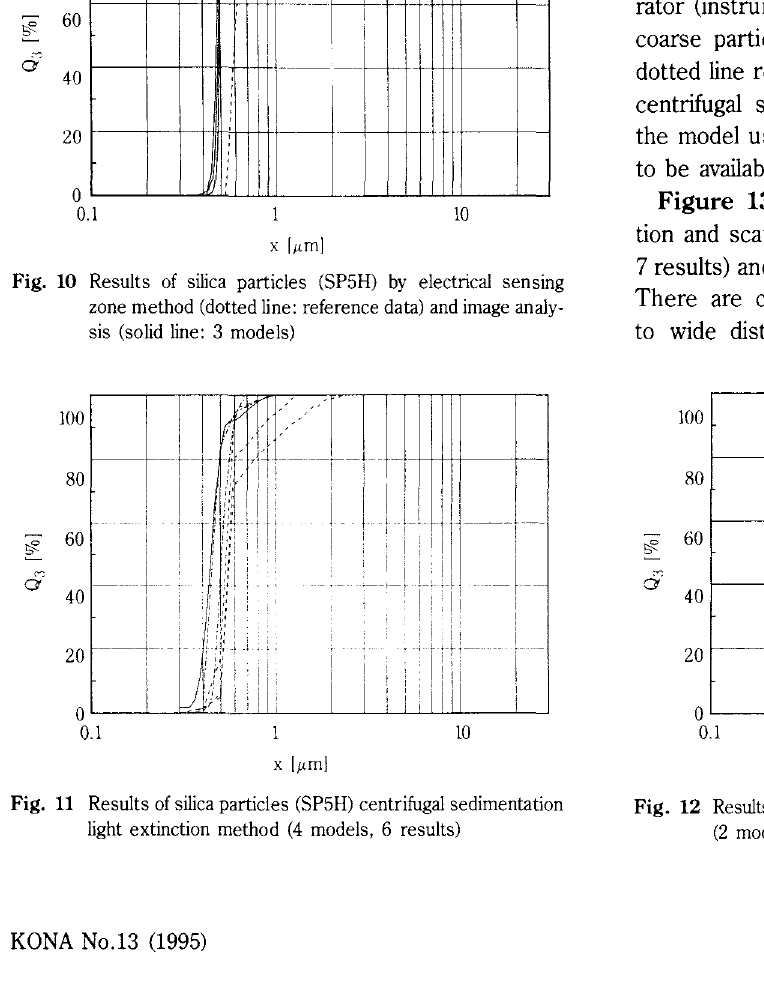
Fig. 10 Results of silica particles (SP5H) by electrical sensing zone method (dotted line: reference data) and image analy sis (solid line: 3 models)